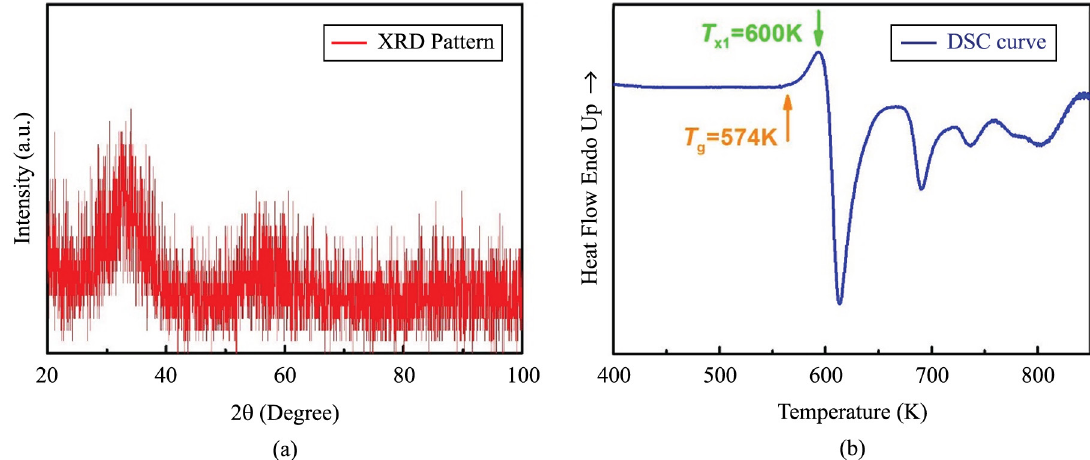
Figure 2. (a) XRD pattern and (b) differential scanning calorimeter (DSC) curve of melt-extracted Gd